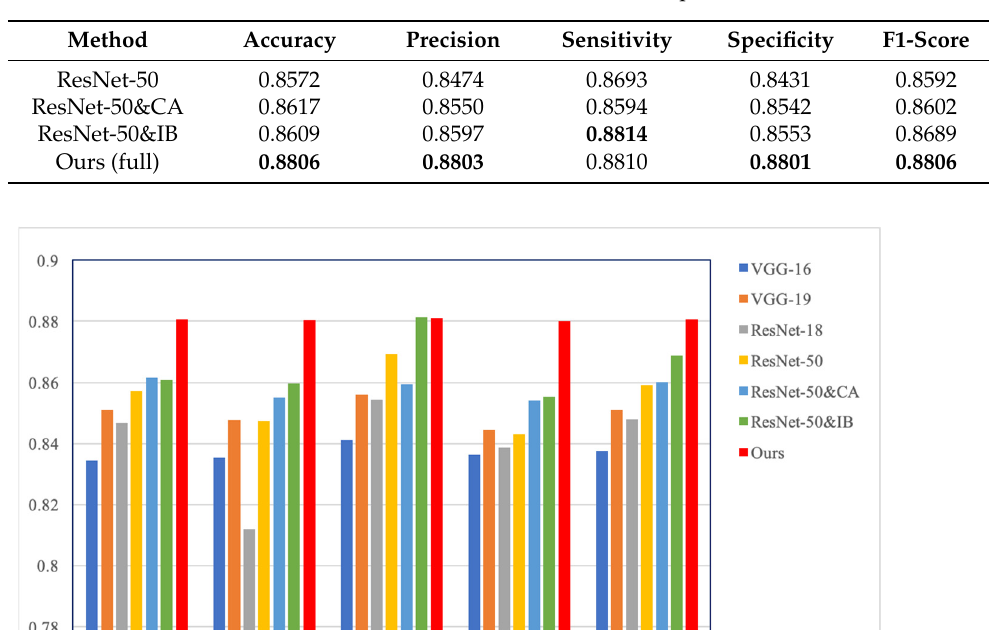
Table 3. Classification results of ablation studies. The bold values represent the best values.